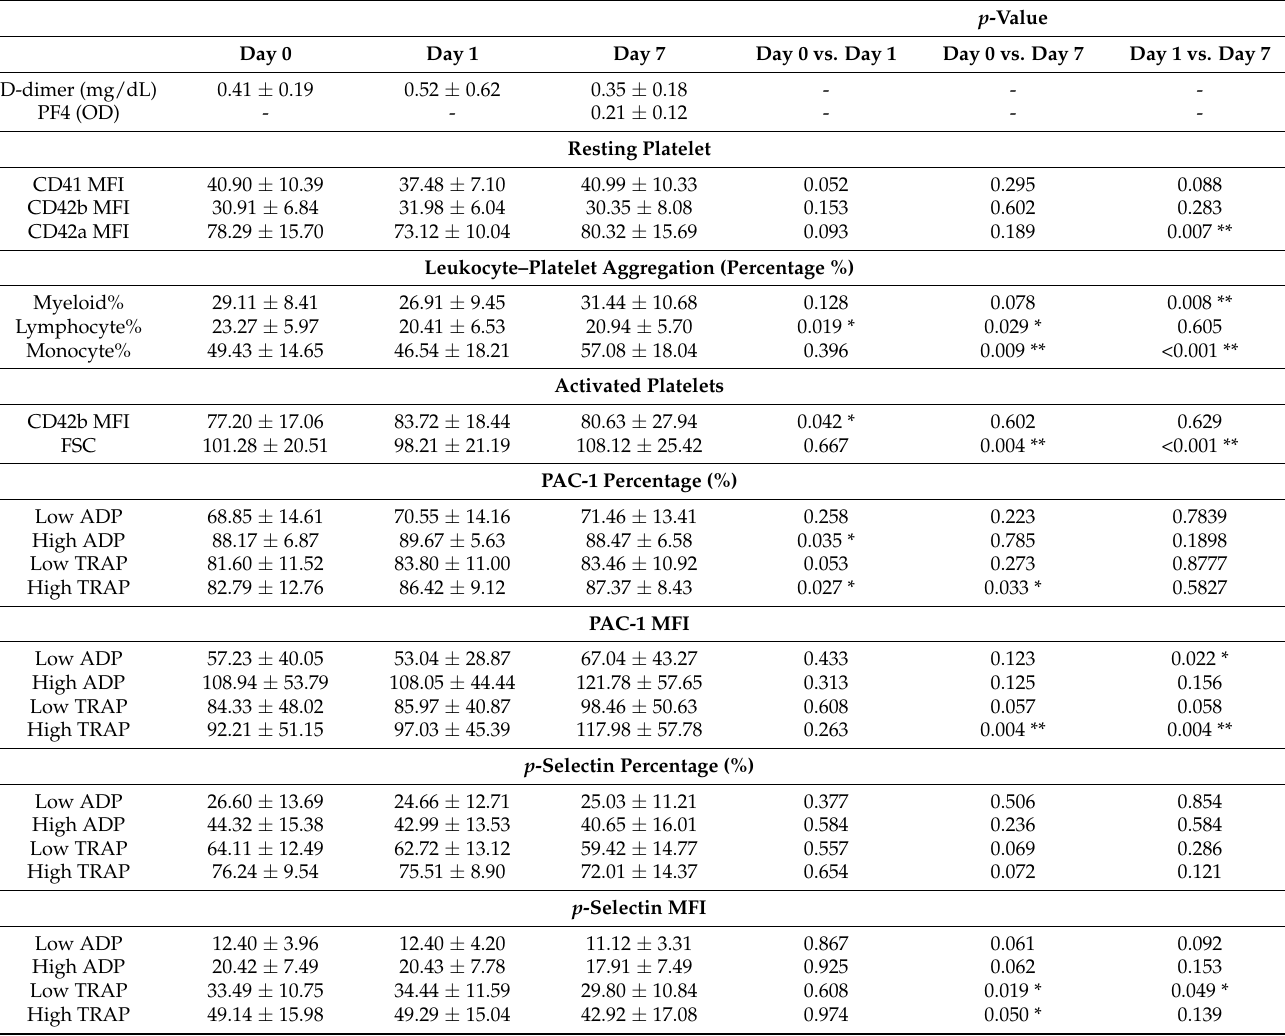
Table 2. Total study results including D-dimer, PF4, MFI of resting platelets, leukocyte–platelet aggregation, expression of GPIIbIIIa (PAC-1), and p -selectin in human platelets before and following the ChAdOx1 nCoV-19 vaccine.